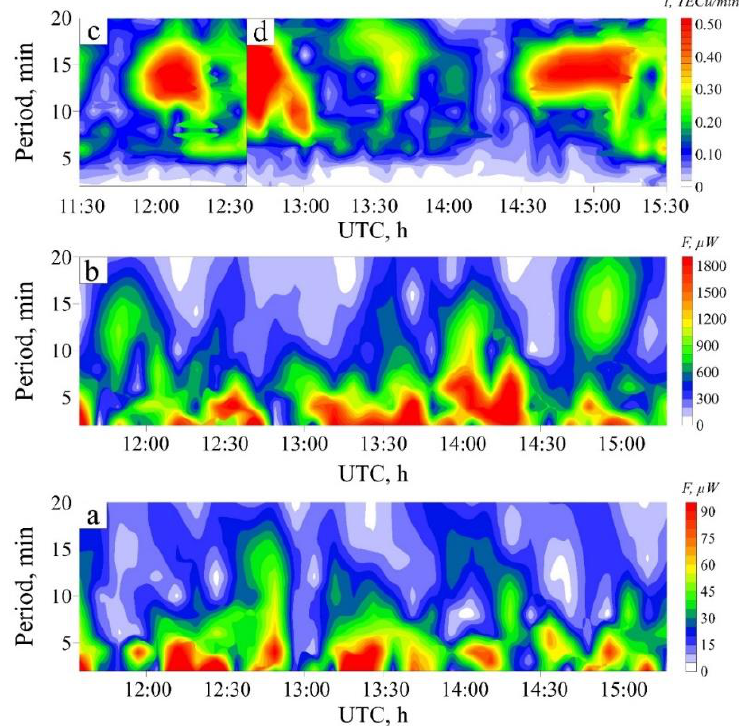
Figure 3. Spectra of variations of the troposphere (bottom and middle row) and ionosphere (top row) parameters during the meteorological storm on 1 April 2016. Lidar measurements were carried out at KLGD station at an altitude of 5650 m at wavelengths: ( a ) λ1 = 1064 nm; ( b ) λ2 = 532 nm . Satellite GPS measurements were performed at the mid-latitude station LAMA: ( c ) PRN 13; ( d ) PRN